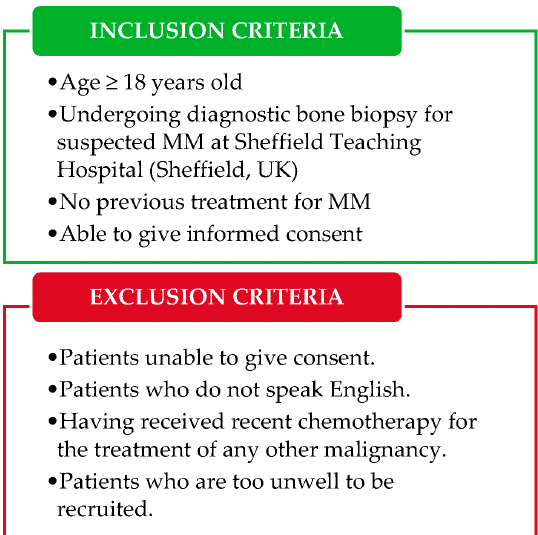
Figure 2. Summary of the patient’s eligibility criteria for the study. MM = multiple myeloma